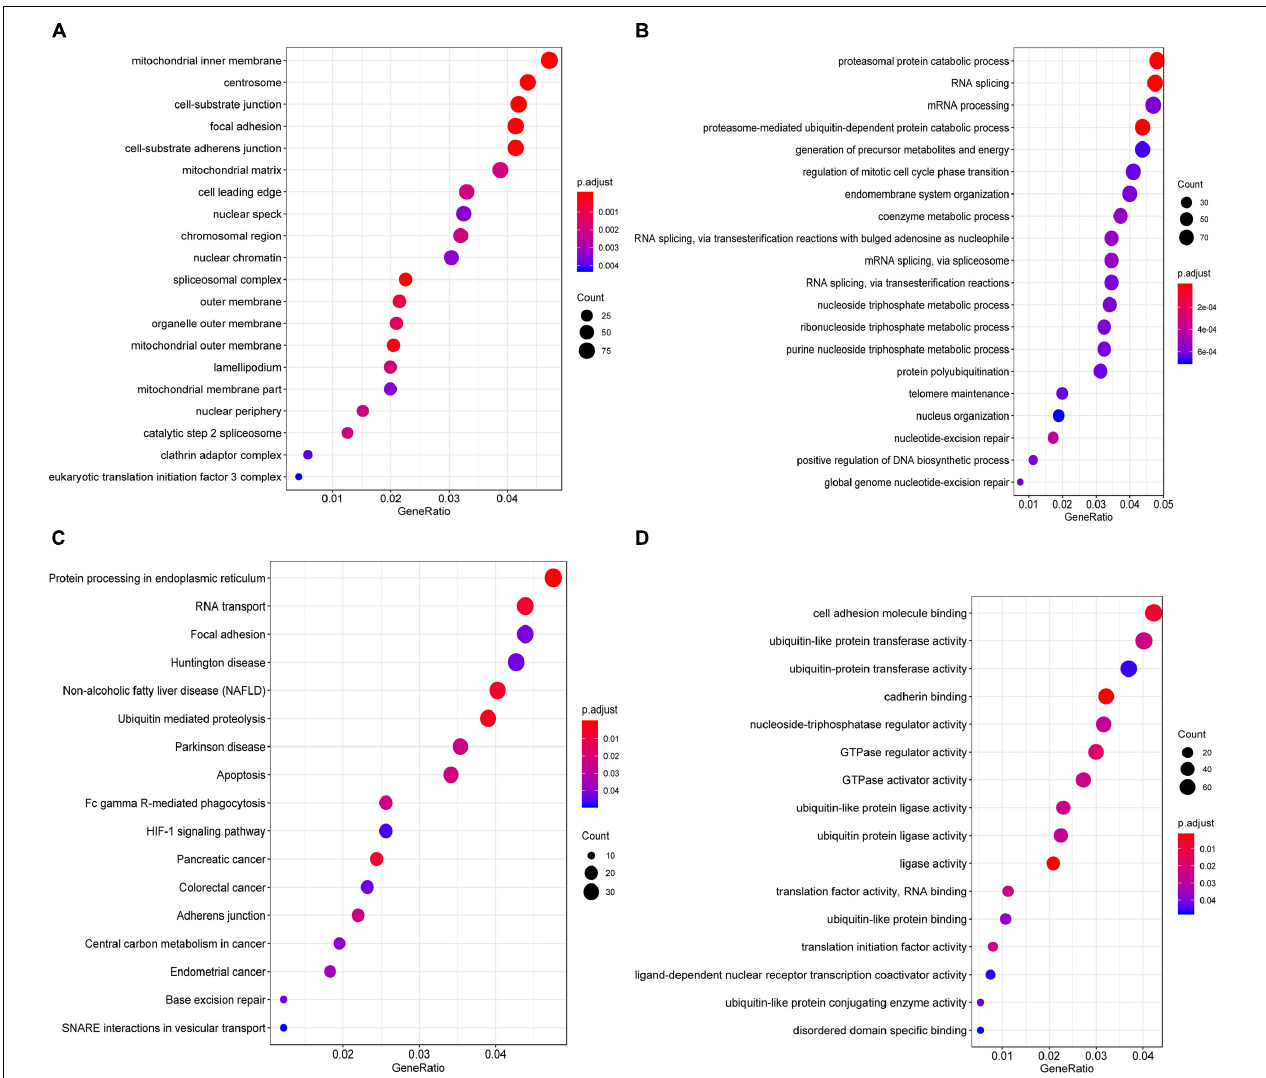
FIGURE 3 | Functional analyses on parent genes from survival-related AS events in BRCA, including GO and KEGG. Top 20 pathways (if available) of GO term in cellular component (A) biological processes (B) molecular function (C), and KEGG pathway (D) analyses of genes from survival associated AS events, respectively. The dot size represents the enriched gene number and FDR values are indicated by color scale by the